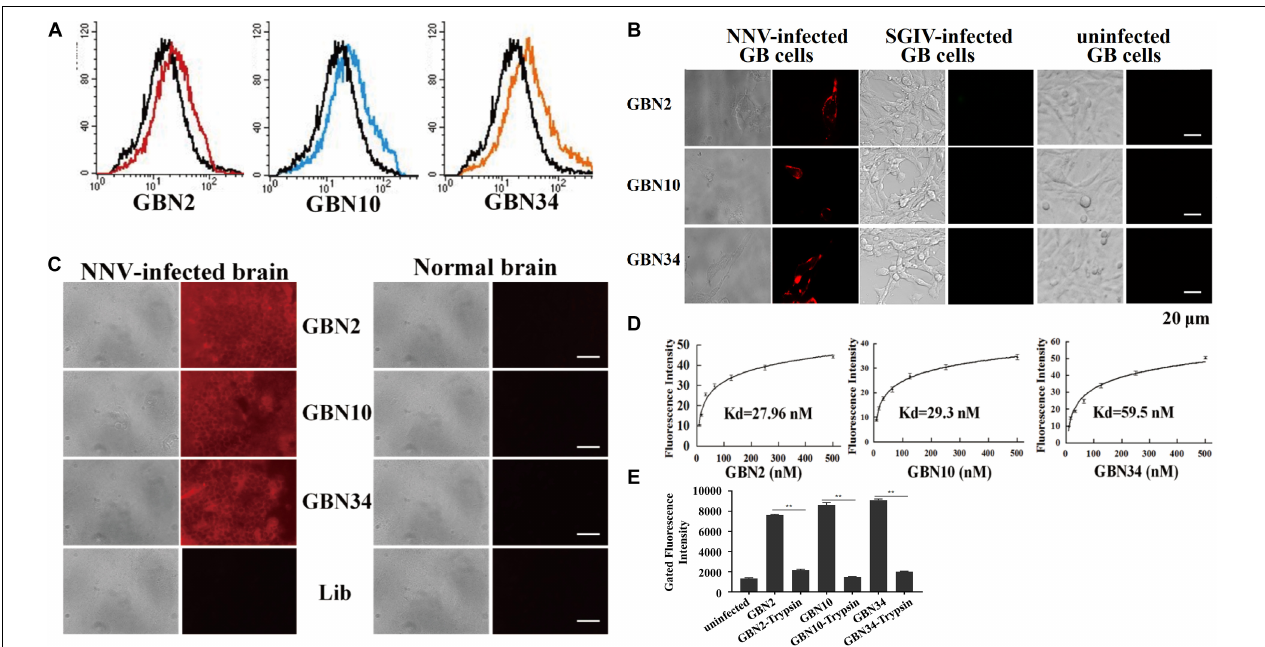
FIGURE 2 | Binding specificity and affinity of three aptamers for RGNNV-infected GB cells. (A) Increased fluorescence intensity revealed the binding ability of each FITC-labeled aptamer (red, GBN2; blue, GBN10; orange, GBN34) for RGNNV-infected GB cells. Each FITC-labeled aptamer was tested against uninfected GB cells as controls (black). (B) Specific binding of each TAMARA-labeled aptamer to RGNNV-infected GB cells, SGIV-infected GB, or uninfected GB cells. Left, bright-field microscopy; right, fluorescence microscopy. Scale bars indicate 20 µ m. (C) Fluorescent images of the three TAMRA-labeled aptamers binding to infected brain tissues. Normal brain tissues and the TAMRA-labeled initial library were used as controls. Left, bright-field images; right, fluorescence microscopic images. Scale bars indicate 50 µ m. (D) Affinity of each aptamer for RGNNV-infected GB cells. Binding affinities of GBN2, GBN10, and GBN34 for RGNNV-infected GB cells were 27.96, 29.3, and 59.5 nM, respectively. (E) Changes in fluorescence intensities of aptamers that bound to RGNNV-infected GB cells treated with